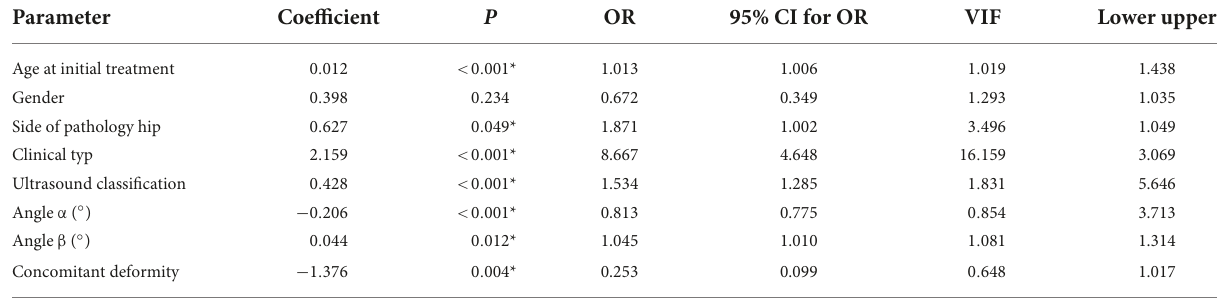
TABLE 2 Univariate logistic regression analysis.